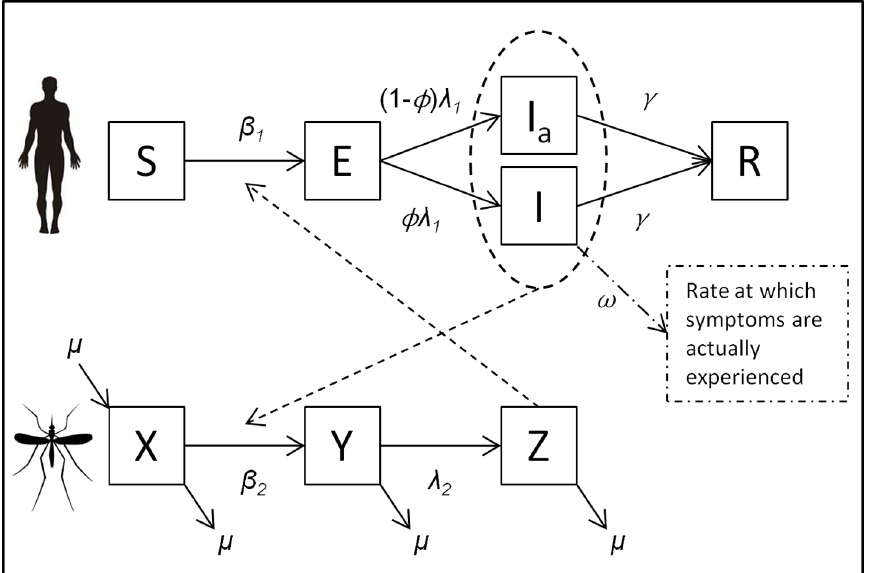
Figure 1. Compartmental construction of the epidemiological model for Chikungunya transmission. Susceptible humans (S) are exposed to infection (E) before becoming infectious (I a asymptomatically, or I symptomatically) and then recover (R). Susceptible mosquitoes (X) are exposed to infection (Y) before becoming infectious (Z). Transmission from mosquito-to-human and vice versa is denoted by the broken lines indicating a mosquito bite. Rates of change between compartments are denoted by corresponding Greek